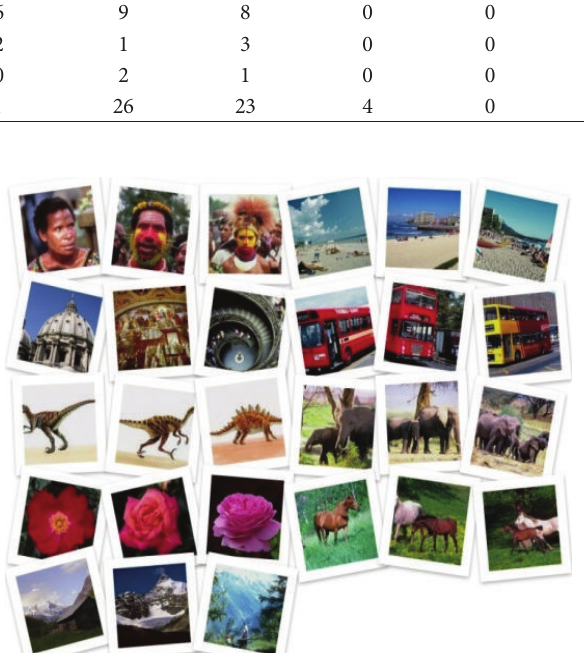
Figure 7: Sample images of different categories from Wang